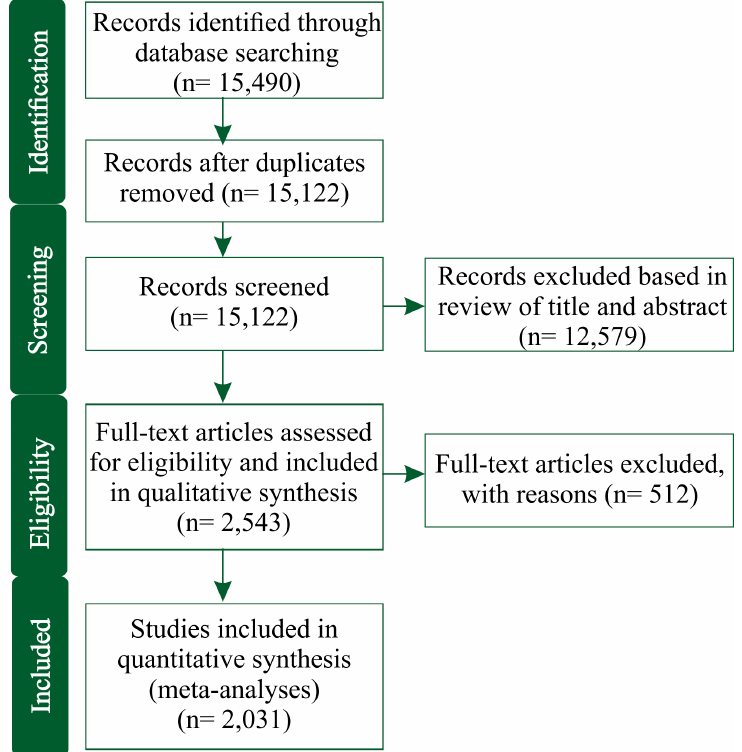
Figure 1. Flowchart diagram describing how scientific articles were gradually included / excluded in the literature dataset at the four stages of the systematic review process (“identification”, “screening”, “eligibility”, and “included”) for subsequent